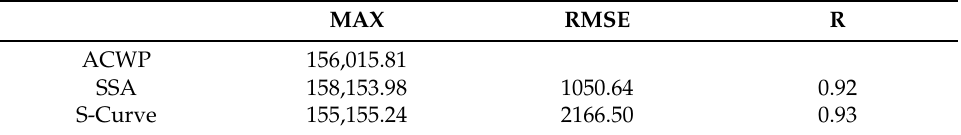
Table 1. Deviations between SSA trend and the S-curve method with the generated time series.